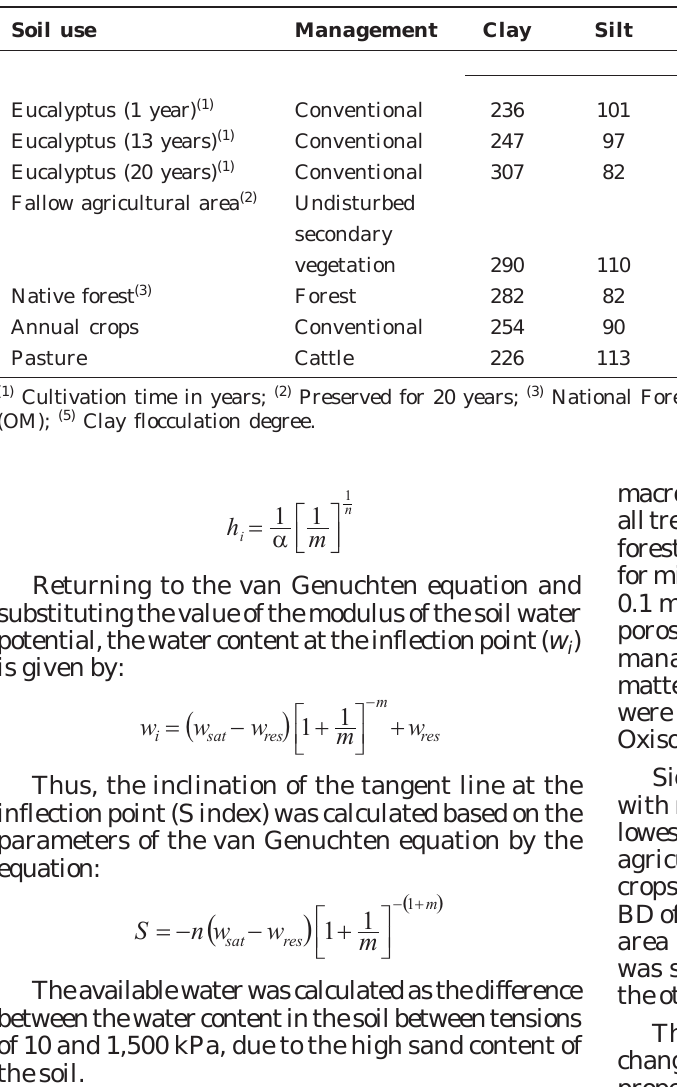
Table 1. Land use management and some physical and chemical properties in the 0-0.1 m layer